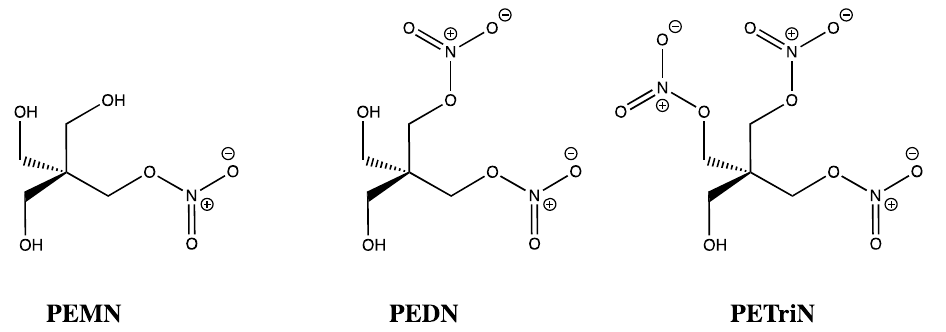
Figure 4. Chemical structures of PEMN, PEDN and PETriN.